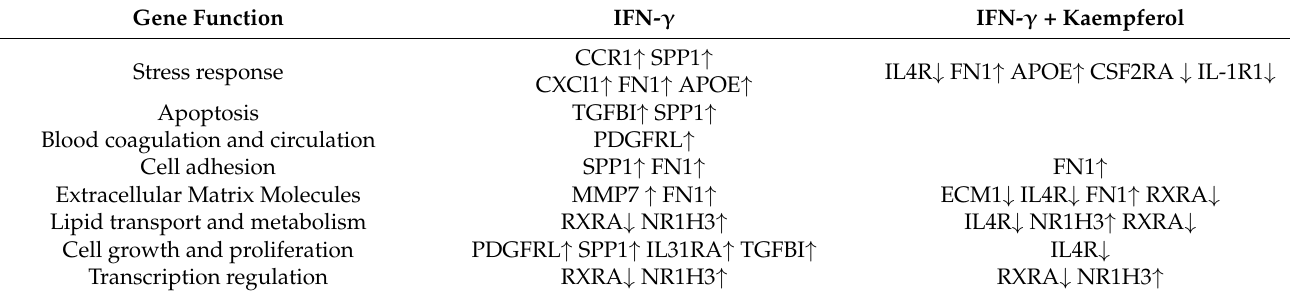
Table 5. Effect of IFN- γ and IFN- γ + kaempferol treatments on the mRNA expression of important genes involved in